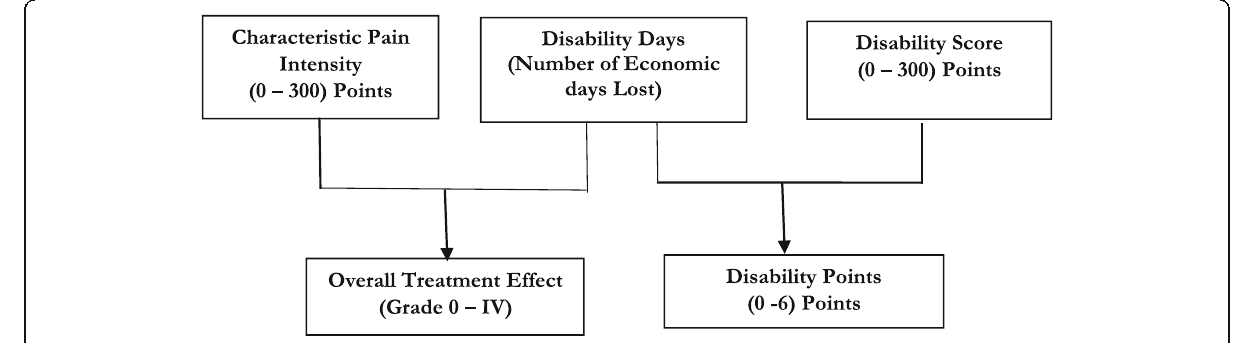
Fig. 2 The Assessment tool - Graded Chronic Pain Scale